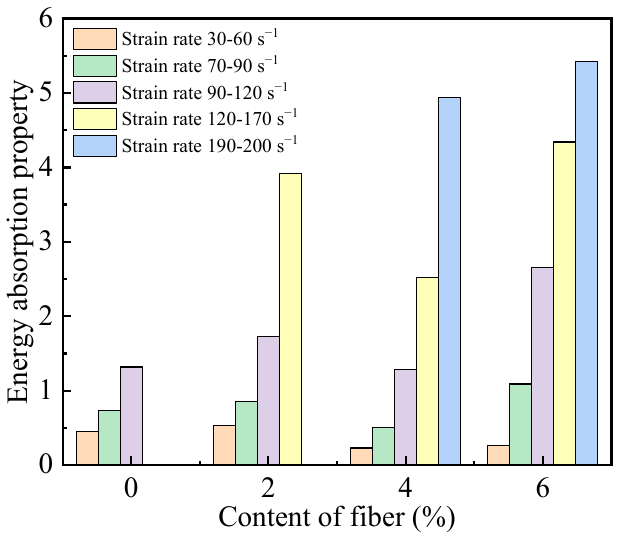
Figure 7. Influence of fiber content on energy absorption property in dynamic impact test (fiber non-oriented).